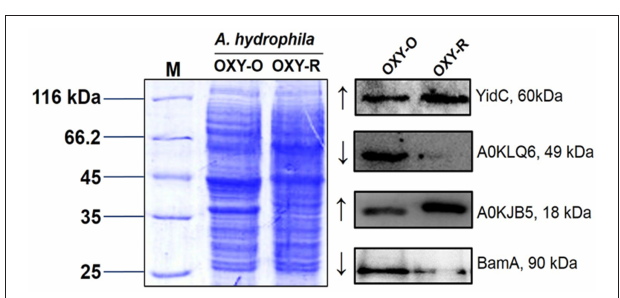
FIGURE 4 | Western blotting to confirm proteomics analyses . Western blot analysis for YidC, A0KLQ6, A0KJB5, and BamA expression compared to OXY-O and OXY-R. Coomassie staining was used as the loading control (on the left). The expected size of YidC, A0KLQ6, A0KJB5, and BamA was 60, 49, 18, and 90 kDa,